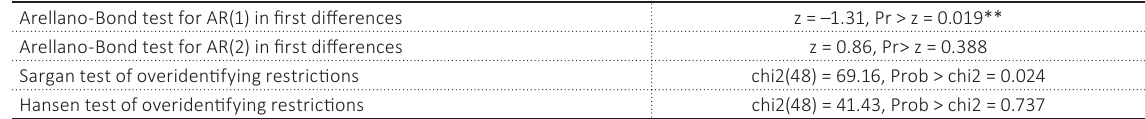
Table 6. Diagnostics test for two-step SYS-GMM Arellano-Bond test for AR(1) in first differences z = –1.31, Pr > z = 0.019** Arellano-Bond test for AR(2) in first differences z = 0.86, Pr> z = 0.388 Sargan test of overidentifying